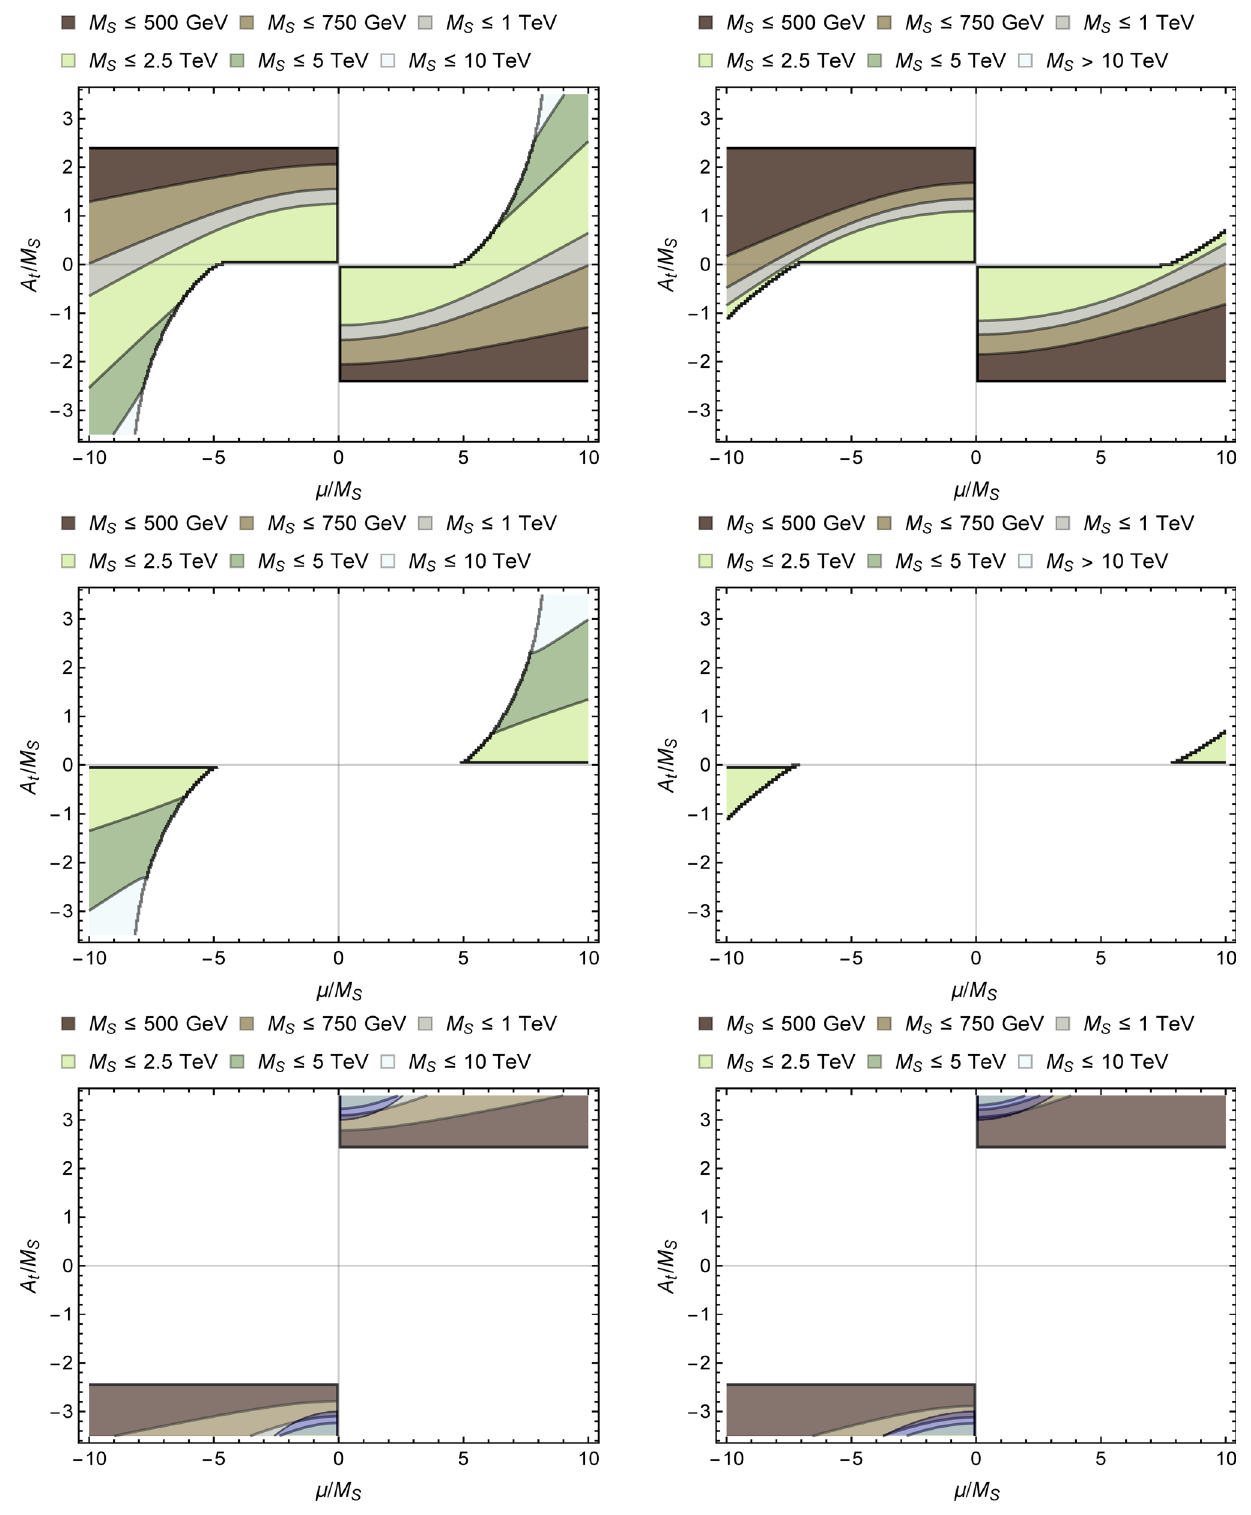
Fig. 4 M S value needed to obtain the correct Higgs mass in the limit of exact alignment, corresponding to the solutions found in Fig. 3 in the (μ/ M , A / M ) plane. Left: Approximate one-loop result; right: two- S t S